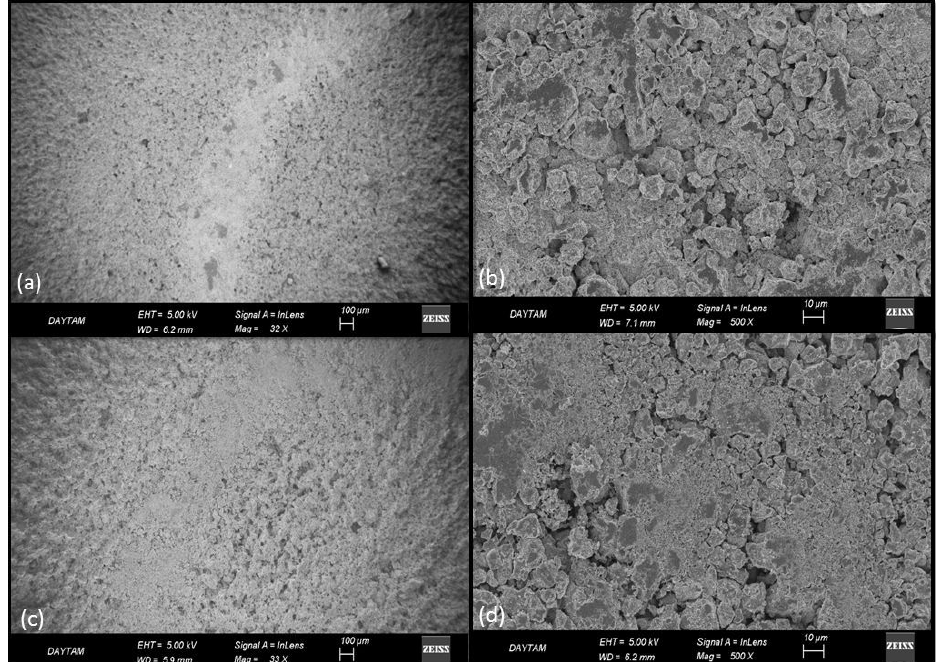
HCO : 80 wt% TiNbZr; c,d) 30 wt% NH 4 3